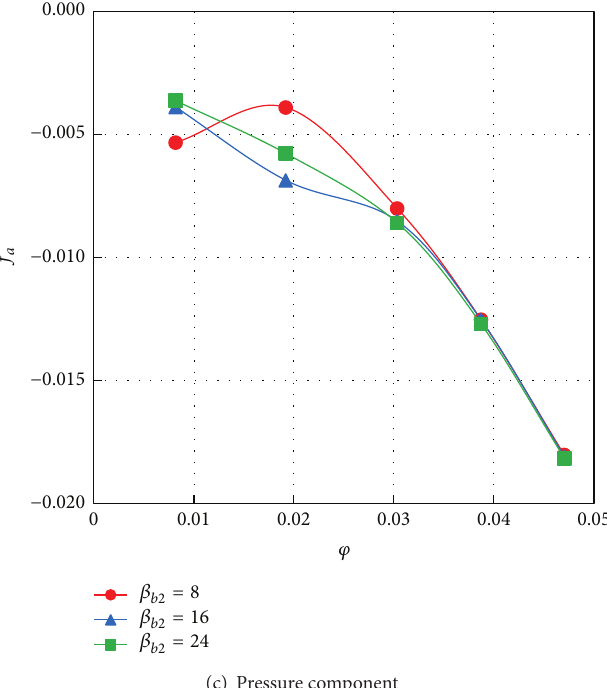
Figure 18: Time-averaged values of each component of axial thrust coefficient ( 𝑓 𝑎 ) as functions of flow rate coefficient ( 𝜑